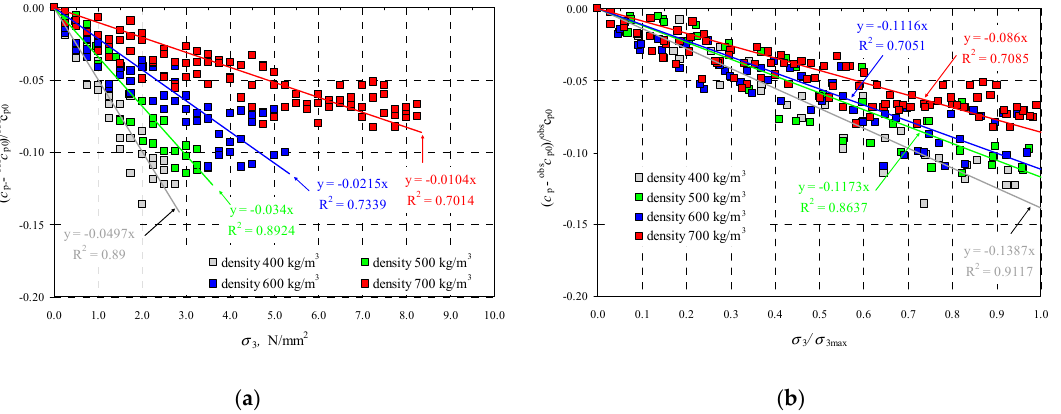
Figure 4. Results from measuring velocity of the longitudinal ultrasonic wave: ( a ) relative change in velocity of longitudinal wave as a function of compressive stress, ( b ) relative change in velocity of longitudinal wave as a function of relative compressive stresses.